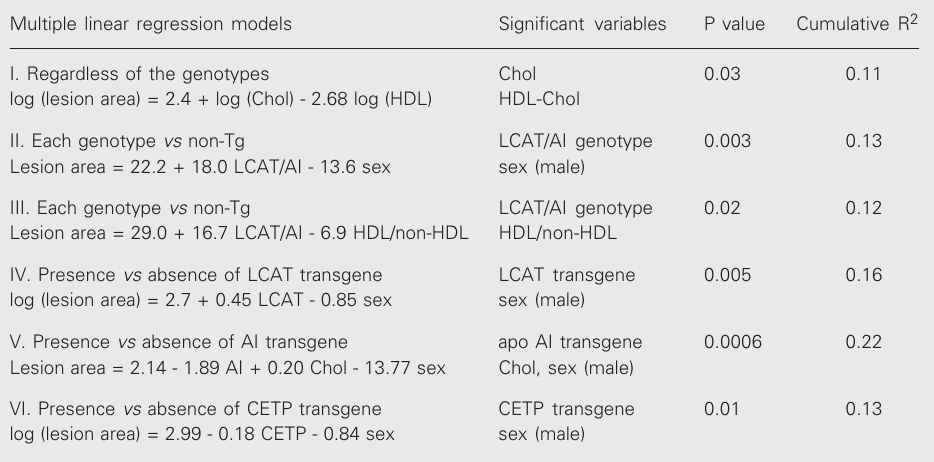
Table 3. Influence (coefficient of determination, R 2 ) of plasma lipids, lipoproteins, genotypes, and sex on the atherosclerotic lesion area in mice expressing combinations of apo AI, LCAT and CETP transgenes. Multiple linear regression